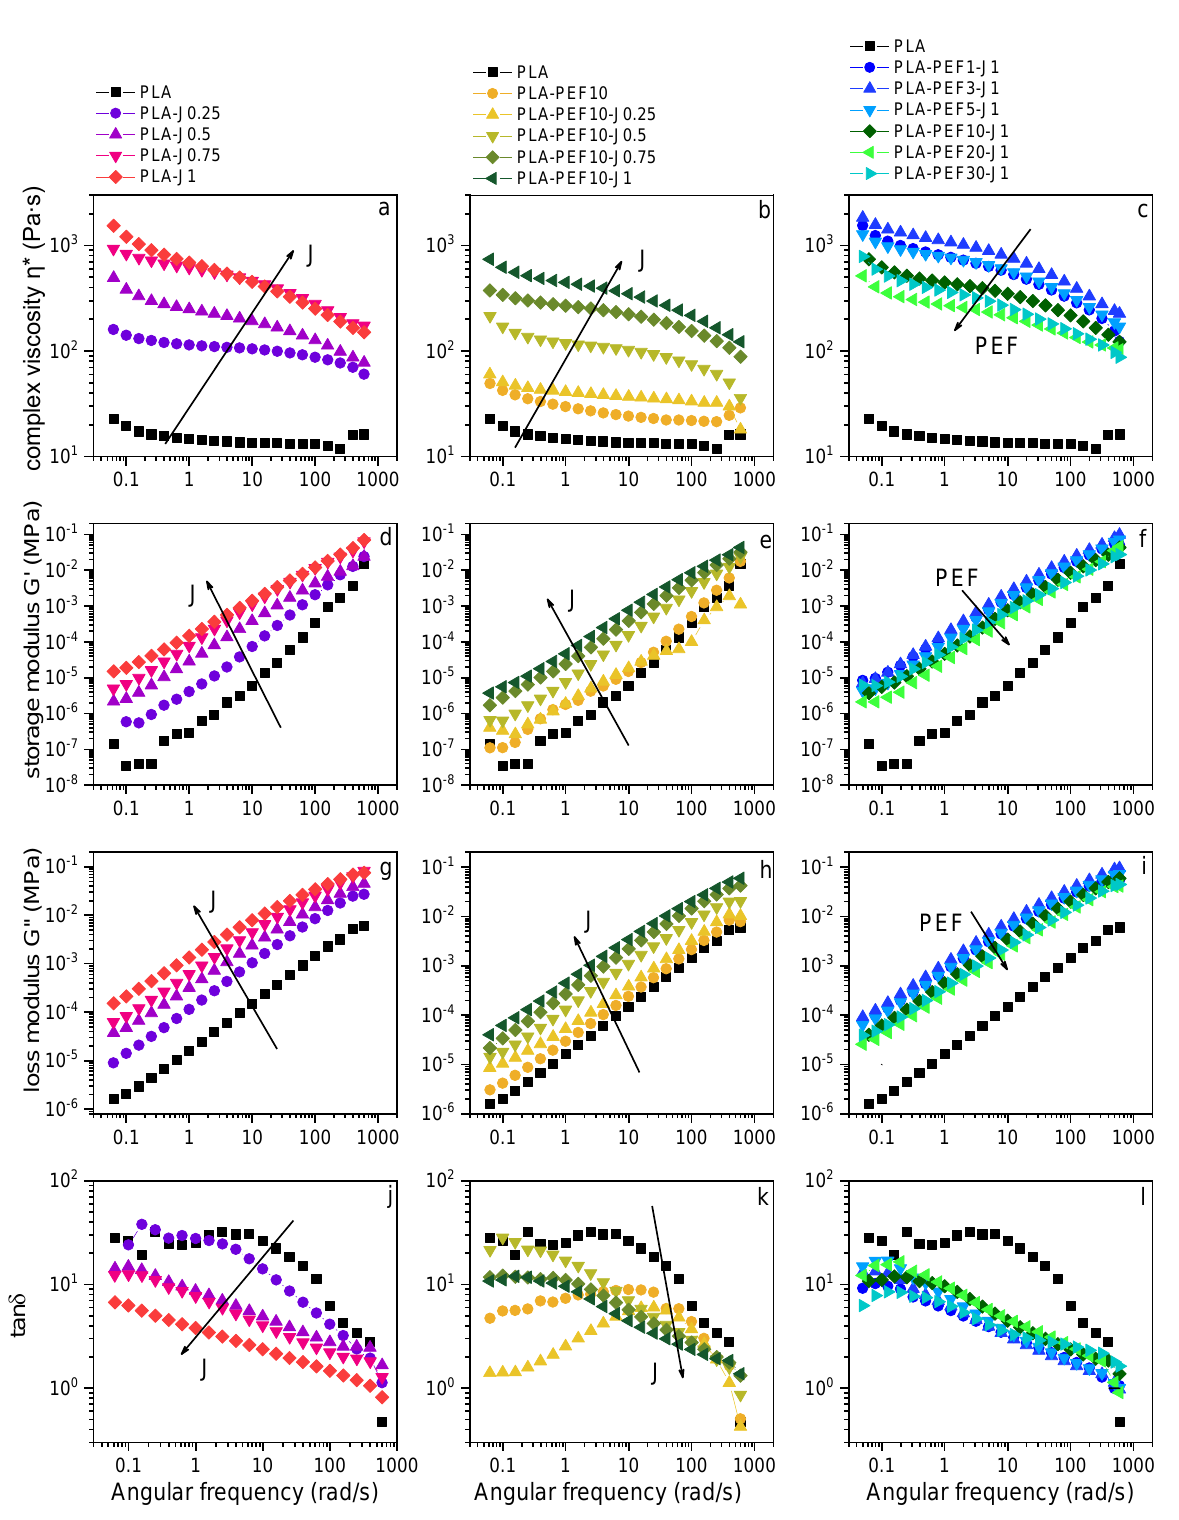
Figure 1. Results of the dynamic rheological tests at 230 ◦ C on the prepared samples. Complex viscosity ( a – c ), storage modulus ( d – f ), loss modulus ( g – i ), and tan δ ( j – l ) as a function of the applied frequency for three series of samples.